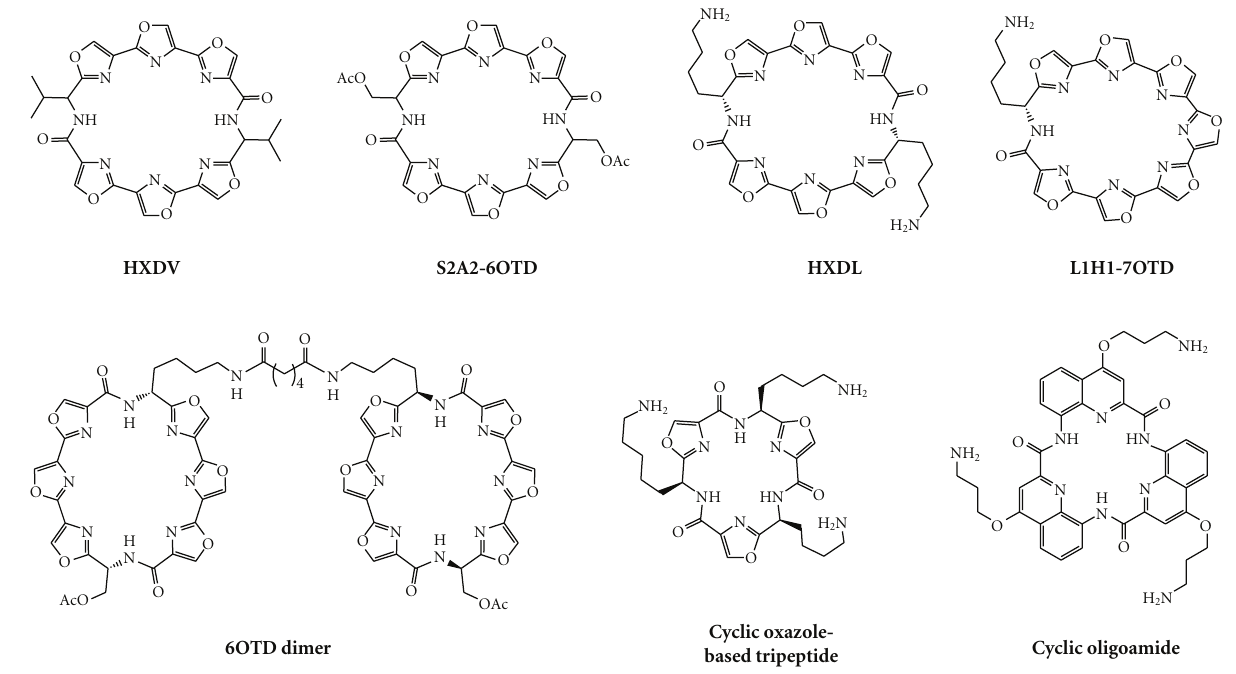
Figure 4: Chemical formulae of telomestatin -related macrocycles.